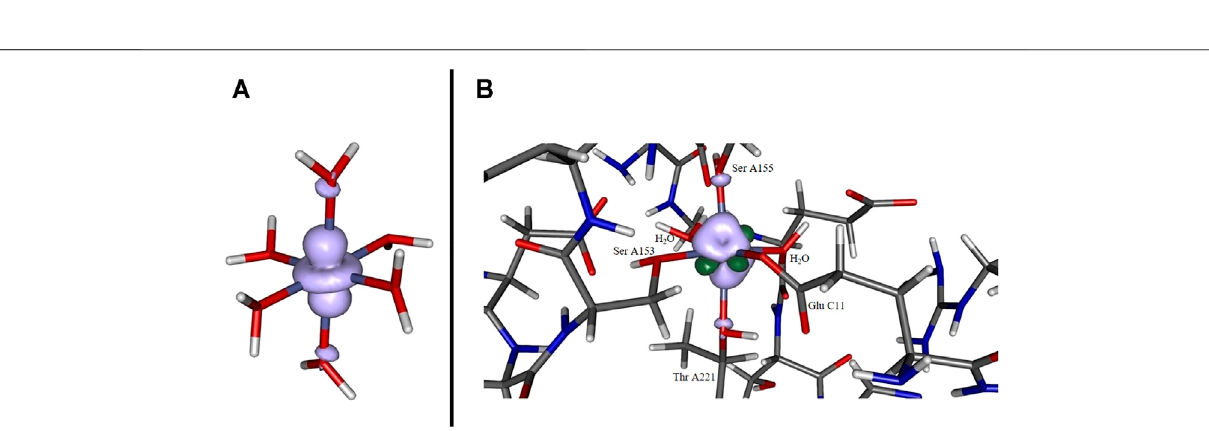
FIGURE 2 | Frontier orbitals obtained at the B3LYP/6-31G* level of theory for [Co(OH 2 ) 6 ] 2+ (panel A) and [Co(OH 2 ) 6 ] 3+ (panel B) , orbital occupation sketched for clarity.